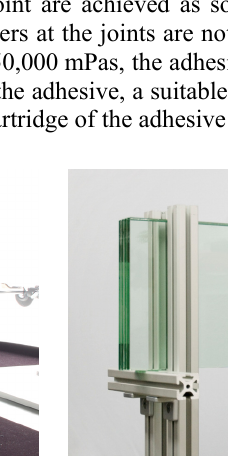
Figure 6: Studies of curing parameters - haze of the adhesive after curing with intense radiation power.